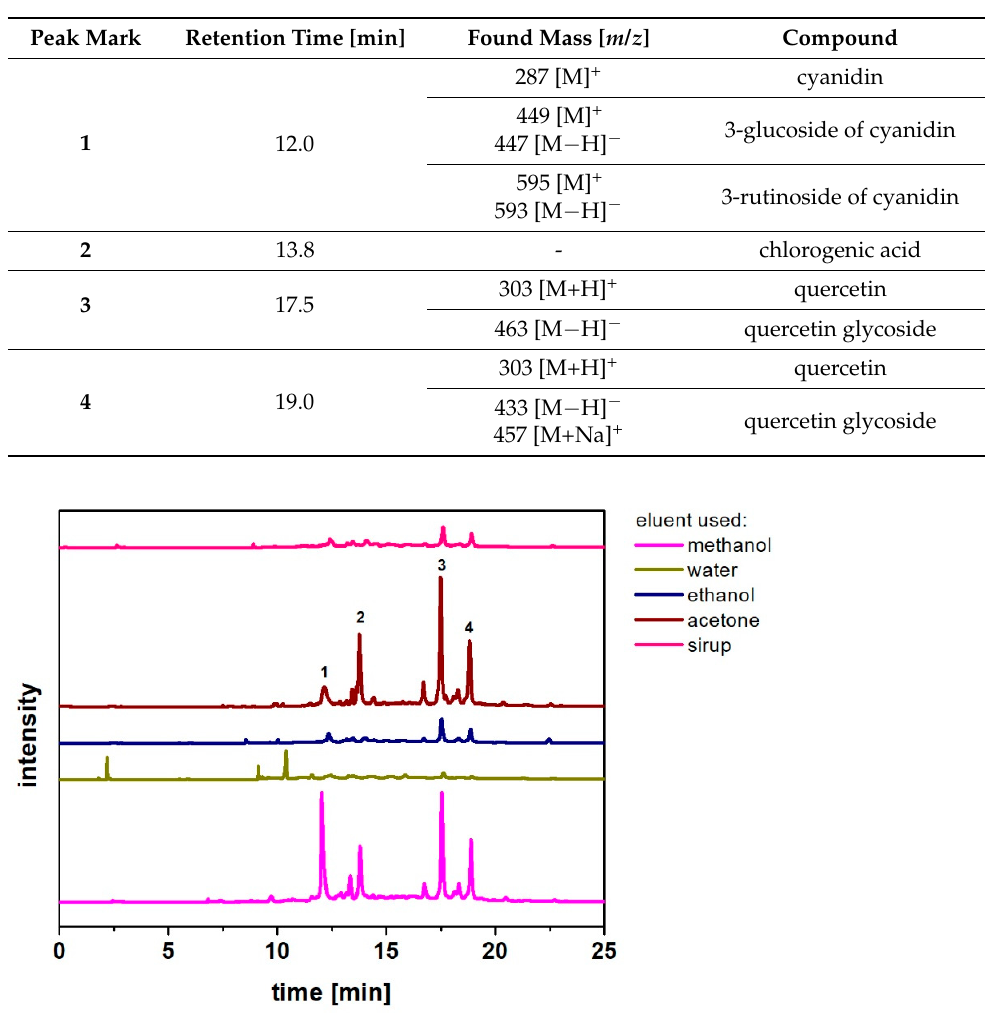
Table 1. The list of compounds found in nonaqueous extracts with possible identification.